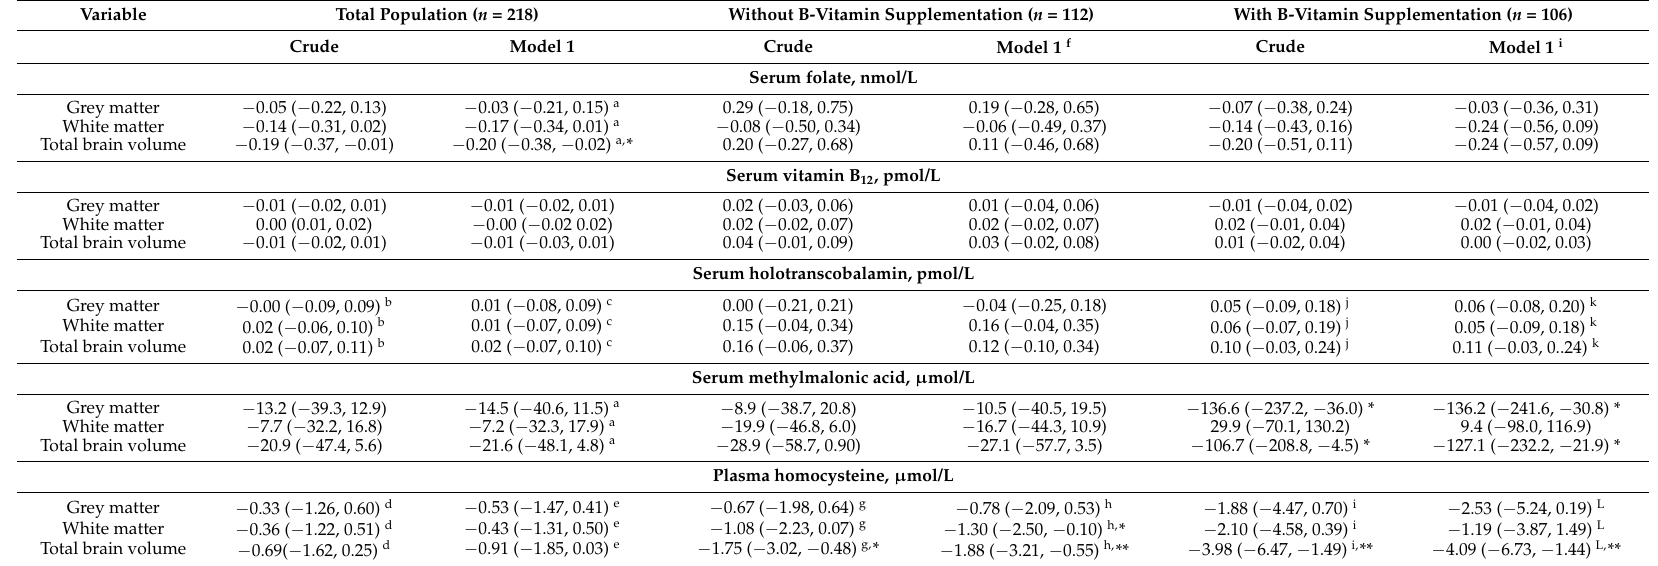
Table 2. Associations between follow-up blood values and brain MRI measures in the total population ( n = 218) and stratified for the group with ( n = 106) and without a history of B-vitamin supplementation ( n = 112) ( β -coefficients (95% CI confidence interval).